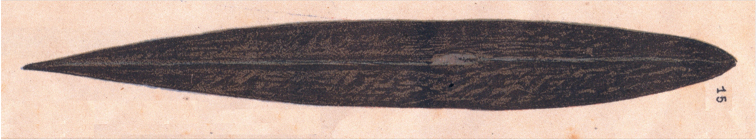
Original illustration of G.
blaseri by Schirch (1929).